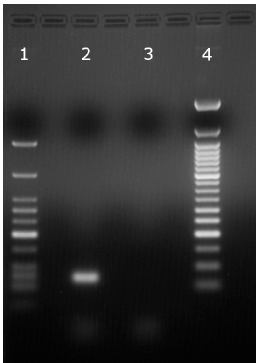
Figure 18. The analysis of translocated ssDNA performed by gel electrophoresis (2% agarose) after PCR amplification. (1) Low Molecular Weight Marker (25–766 bp), New England Biolab; (2) Amplicon produced from ssDNA molecules translocated through lysenin channels; (3) The absence of DNA indicates that a reversed polarity prevents translocation. (4) 50 bp Ladder Marker, New England Biolabs.